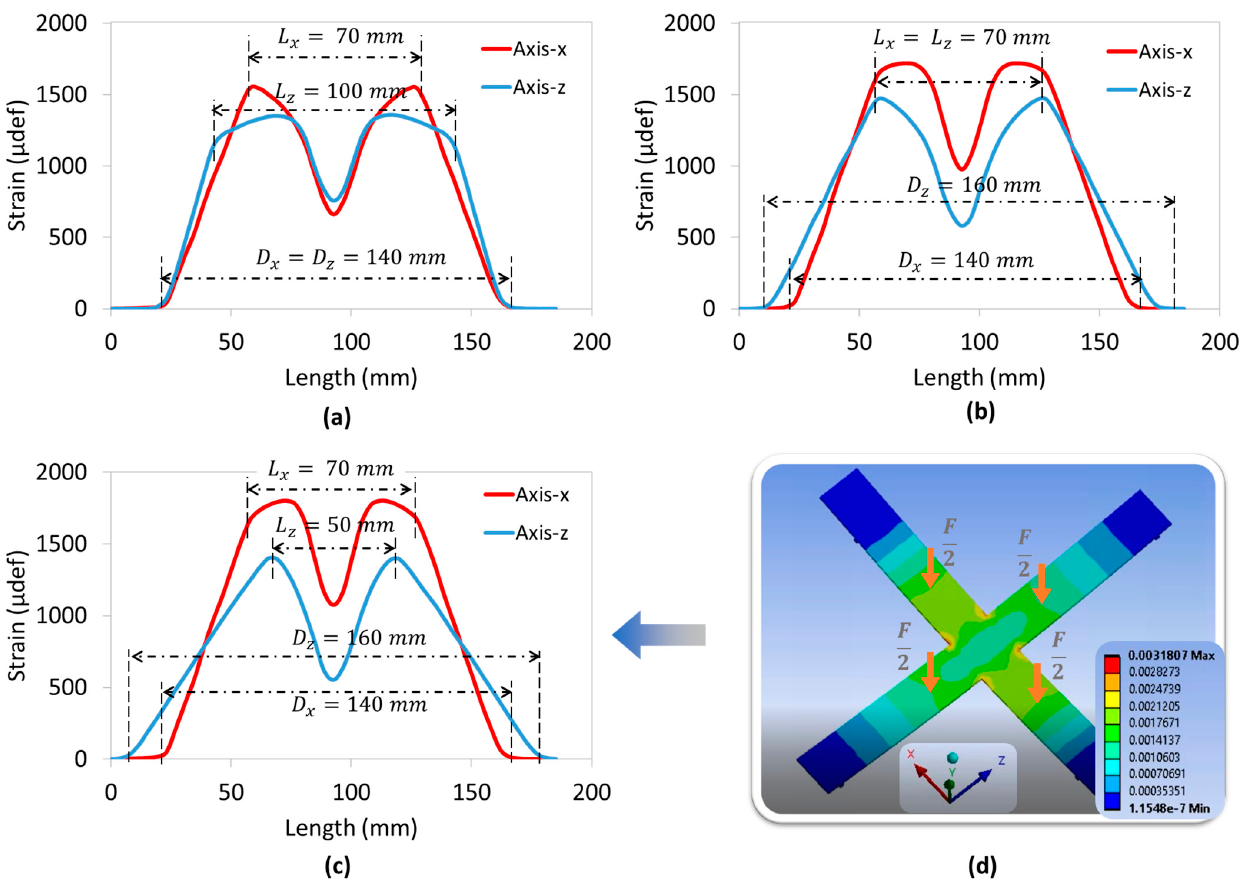
Figure 7. Symmetric bidirectional symmetrical model using FEM: ( a ) four-point flexure design with load applied on x- and z -axis ( 𝐿 (cid:3051) = 𝐿 (cid:3053) and 𝐷 (cid:3051) = 𝐷 (cid:3053) ); ( b ) strain in both x -axis and z -axis versus their own length.